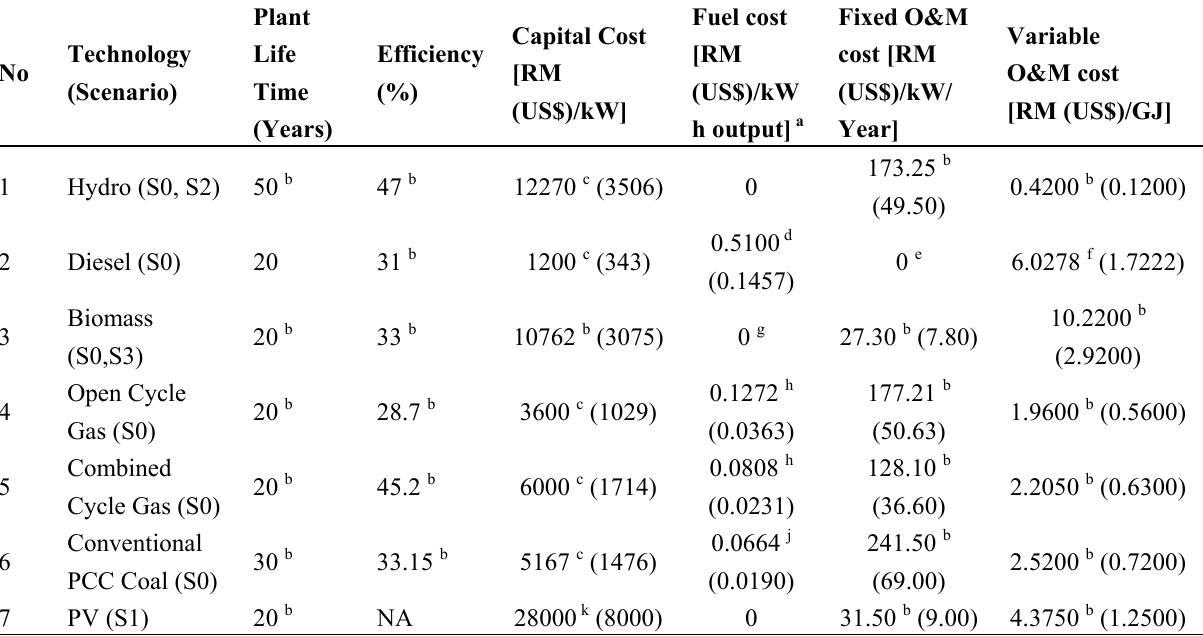
Table 2. Key parameters for cost analysis in